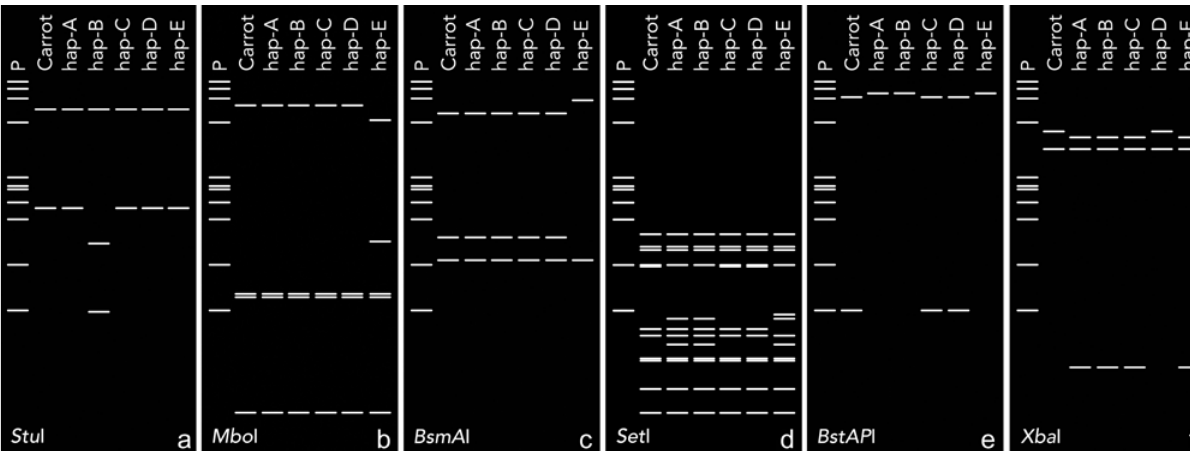
Figure 3. Virtual RFLP gel with selected restriction enzymes showing the polymorphisms among ‘ Ca . L. solanacearum’ detected in carrot and the diverse haplotypes reported on full length OA2/O12c sequences, obtained in this work (Carrot) and retrieved from Genbank. Enzymes used are reported at the bottom of each gel. P, marker phiX174 Hae III digested with fragment sizes in base pairs from top to bottom of 1,353; 1,078; 872; 603; 310; 281; 271; 234; 194; 118 and